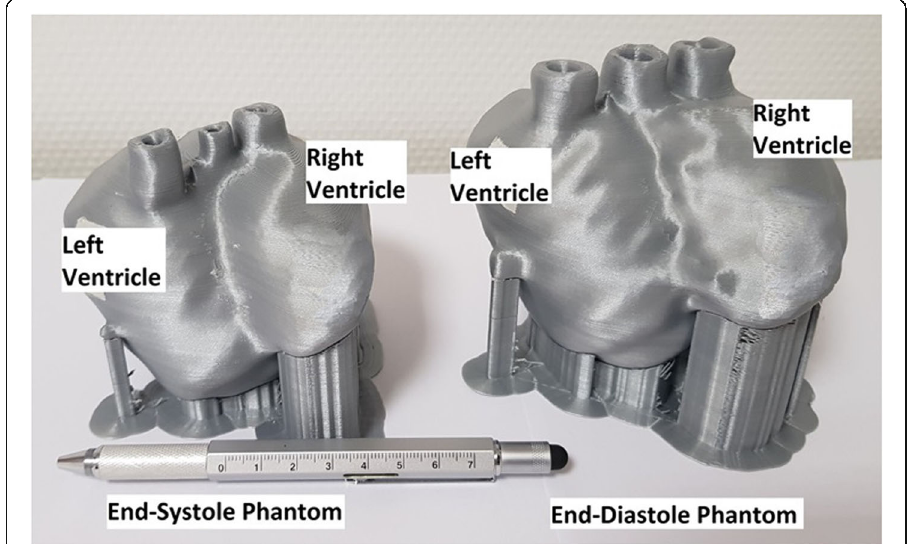
Reference LVEF value The left ventricular end-diastole volume (EDV) and end-systole volume (ESV) reference values were 110 and 62 cm 3 , respectively. They were used with formula (1) to calculate the reference LVEF, which was 43.6% (Table 2).